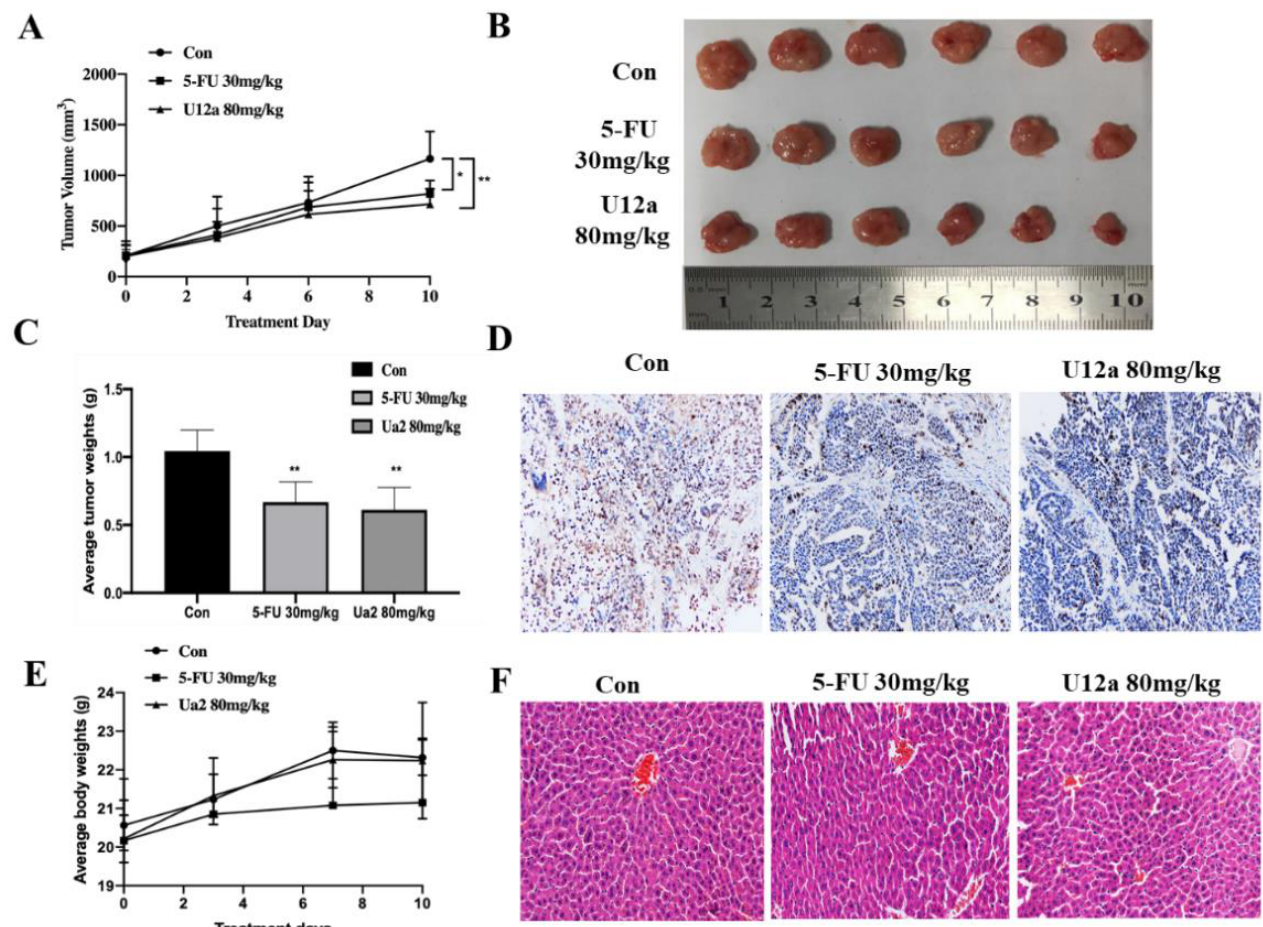
Figure 6. In vivo effects of U12a in the hepatocellular carcinoma (HCC) nude mouse xenograft model. ( A ) Average tumor volume of different groups (0, 5-FU 30 mg/kg, U12a 80 mg/kg). ( B ) Tumor size and weight of different groups. ( C ) Average tumor weight of different groups. ( D ) Tumors were excised and processed for immunostaining for Ki-67. ( E ) Average body weight of nude mice. ( F ) H&E staining of liver from different groups (0, 5-FU 30 mg/kg, U12a 80 mg/kg). Data represented mean ± SD ( n = 6). * p < 0.05, ** p < 0.01 compared to control.